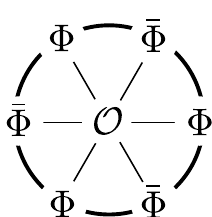
Figure 14 . The contractions between a single-trace operator and a PCGG. The alternating sequence of (cid:8) and (cid:22)(cid:8) creates a boundary of the ’t Hooft surface and the contraction has topology of a disk with one